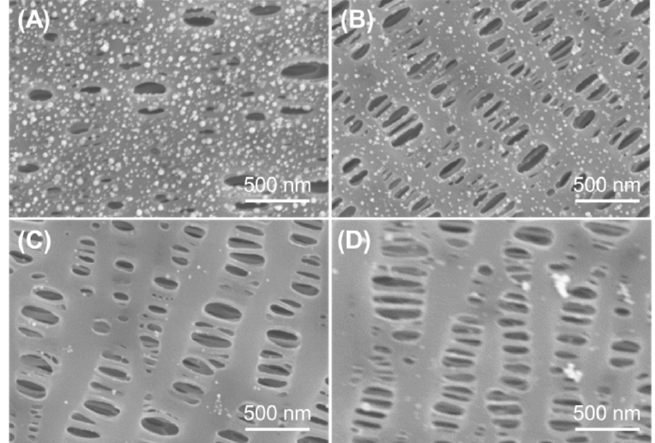
Figure 1. SEM images of PP-TA / Au separator prepared in HAuCl 4 bath with di ff erent pH values: ( A ) pH 4; ( B ) pH 6.8; ( C ) pH 7.6 and ( D ) pH 8.3.